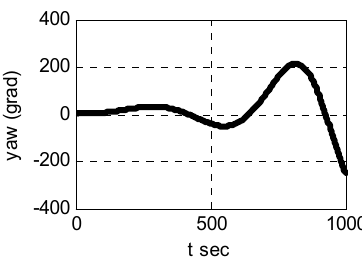
Figure 5. Graphs of the function y ( t ) for closed-loop connection (33), (24) in Regime 1 of motion for the time delay h = 6 s (a loss of stability).